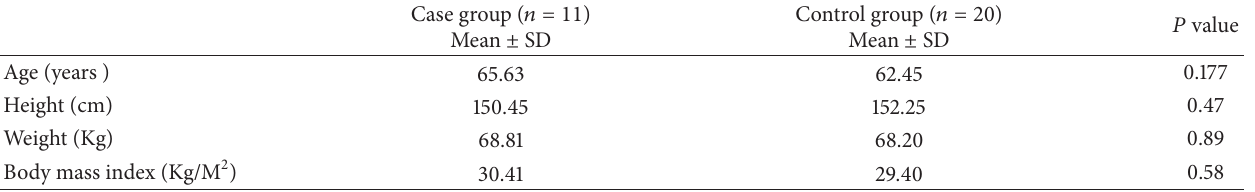
Table 1: Demographic characteristics including age, height, weight, and body mass indices compared between two